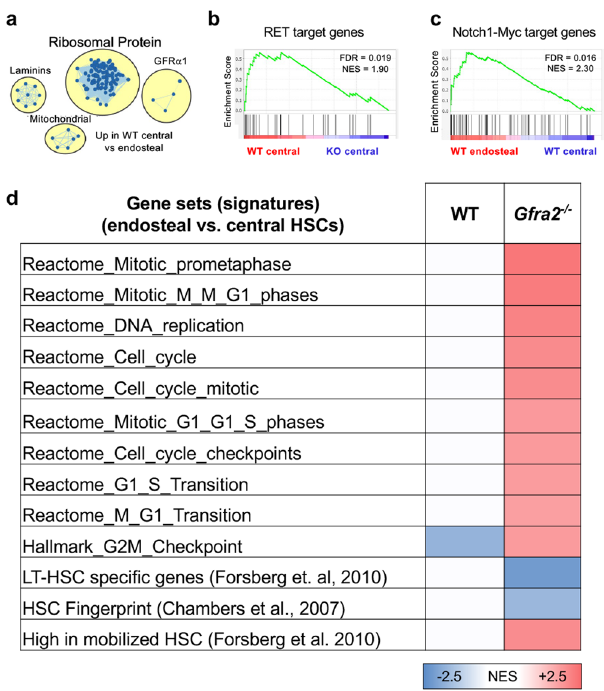
Fig. 5 Reduced quiescence and self-renewing programme in endosteal HSCs from cholinergic-neural-de fi cient mice. Gene sets enrichment analysis (GSEA) comparing endosteal and central lin − CD48 − sca1 + ckit + CD150 + HSCs of WT mice and Gfra2 − / − mice ( N = 4 biological replicates). a Enrichment map showing upregulated pathways in central (compared with endosteal) BM HSCs. b Downregulation of RET target genes in HSCs from Gfra2 − / − mice. c Enriched Notch1-Myc target gene expression in endosteal WT HSCs. d Datasets from the Reactome, Pathway Interaction Database and Hallmark database as well as published HSC datasets were used for comparison. The normalised enrichment score (NES) of signi fi cantly enriched datasets (False discovery rate (FDR) < 0.1) is depicted as heatmap. Red, blue, and white colours indicate upregulation, downregulation, and no change,